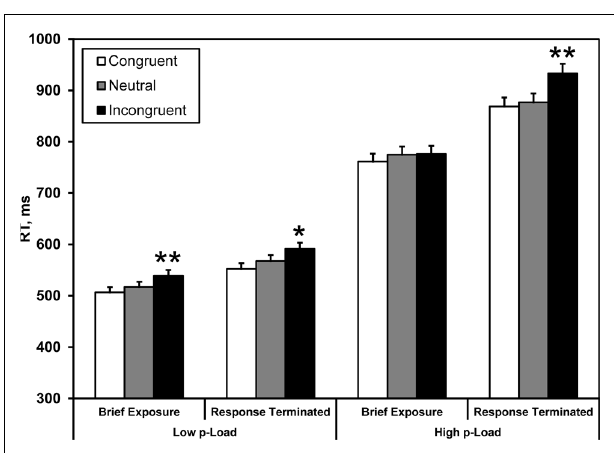
FIGURE 3 | Mean correct RT in Experiment 1. Briefly exposed stimuli were presented for 100 ms – all other stimuli were response-terminated. Asterisks denote significance from neutral condition: * p < 0.05, ** p < 0.01. Error bars represent 95% within-observers confidence intervals (Loftus and Masson, 1994; Morey, 2008).